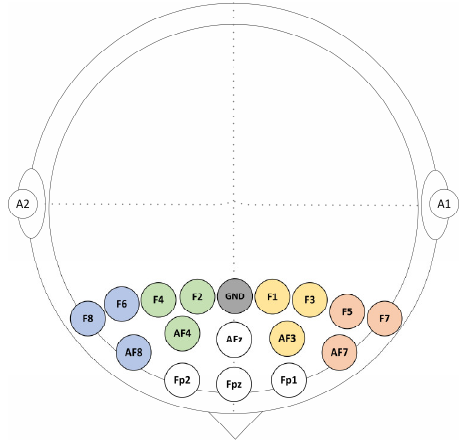
Figure 2. Sixteen EEG selected channels were arranged above the prefrontal cortex (PFC).